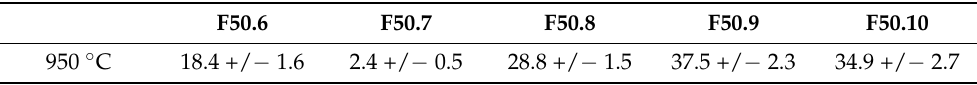
Table 14. The mean efficiency and SD of formulations F50.6–F50.10: EN60754-2 at 950 ◦